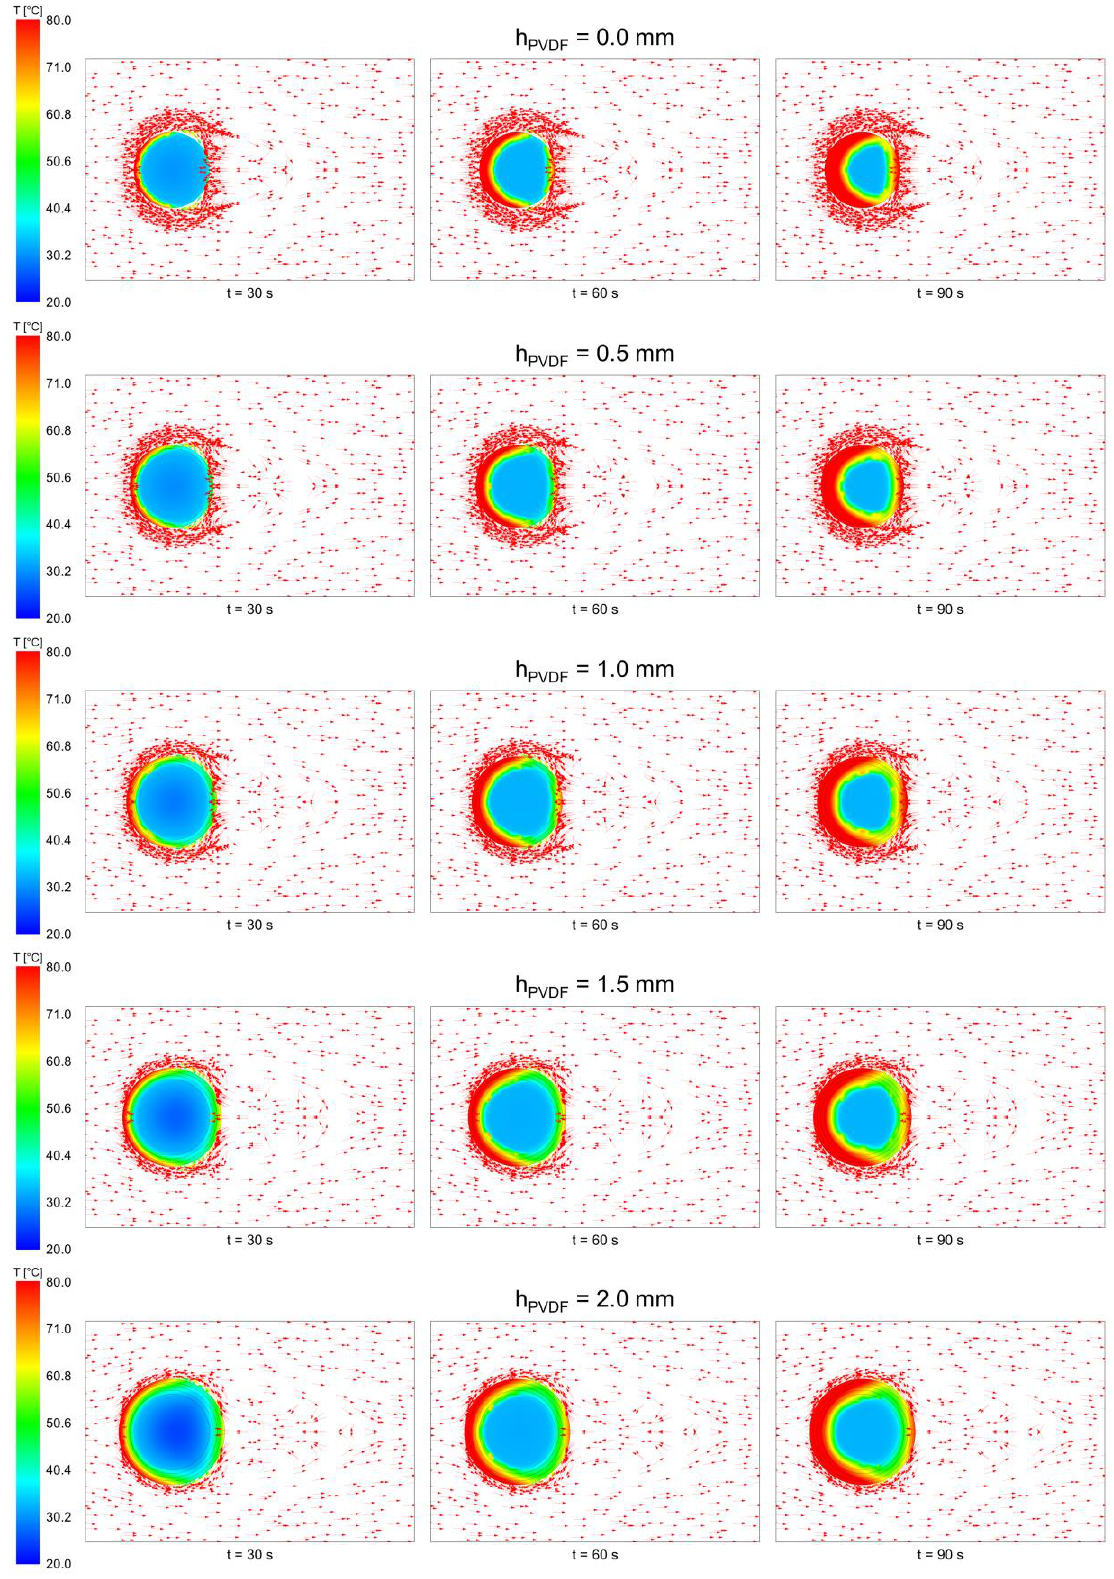
Figure 3. Spatial temperature field of the spherical core-shell particle for different loading times and PVDF shell thicknesses under laminar flow conditions with an ammonia inflow velocity of 2 m/s.